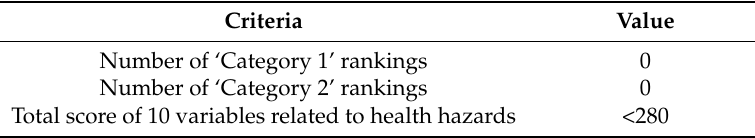
Table 3. The process of selecting chemicals that are relatively less